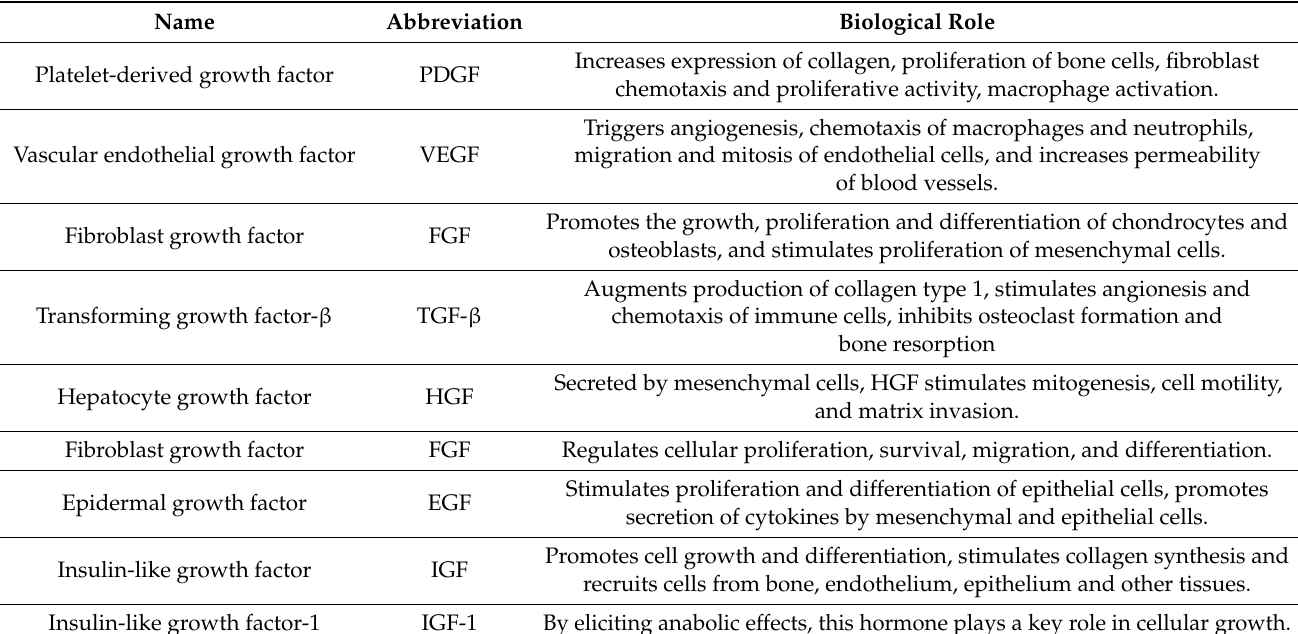
Table 1. The biological role of growth factors present in platelet α